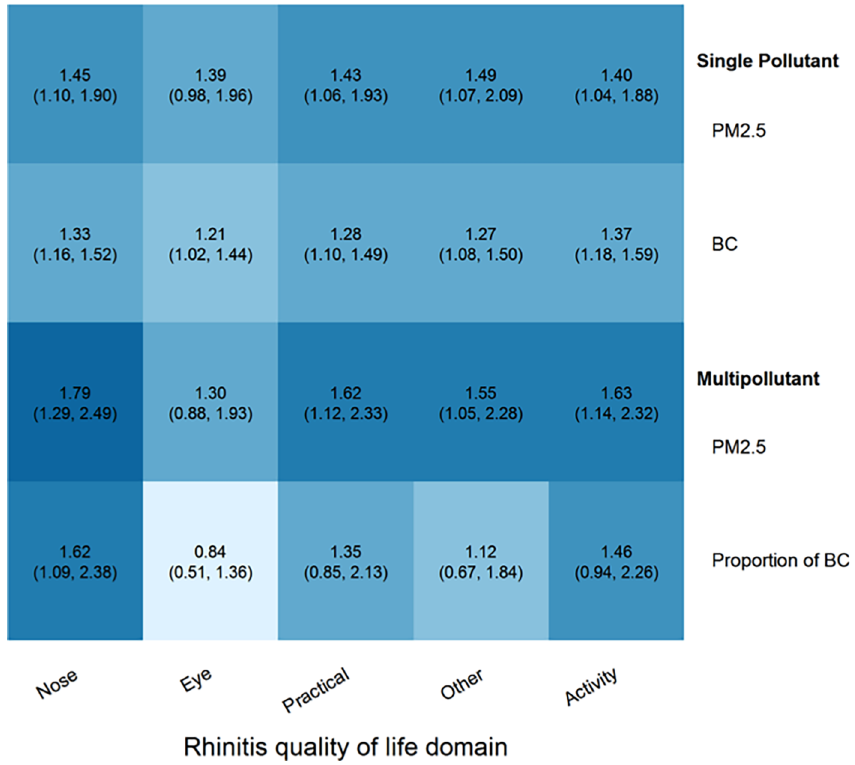
Fig 1. Single and multi-pollutant associations of PM 2.5 and black carbon with rhinoconjunctivitis quality of life, by domain. All models were adjusted for the following covariates: pediatric/adolescent survey, age, sex, socioeconomic status, Cole BMI classification (normal, overweight, obese), site (Pampas, Villa), baseline FEV 1 percent predicted, temperature (˚C) and humidity (%). Increased intensity of color reflects higher odds ratios.